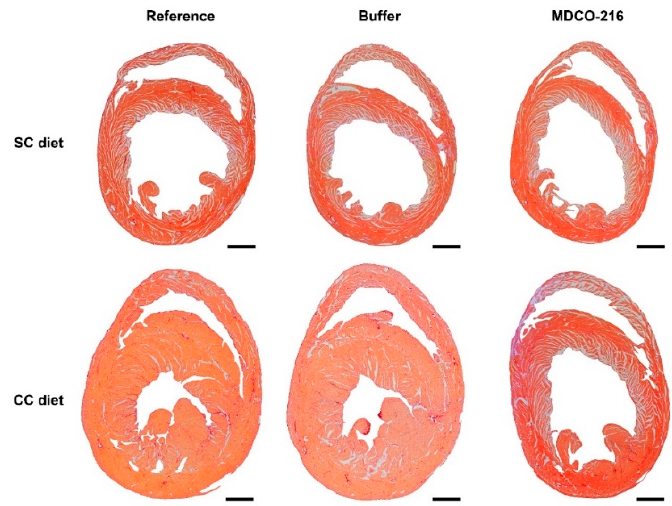
Figure 6. Representative Sirius-red stained cross-sections of reference, buffer, and MDCO-216 SC diet and CC diet mice. Scale bar represents 1 mm.